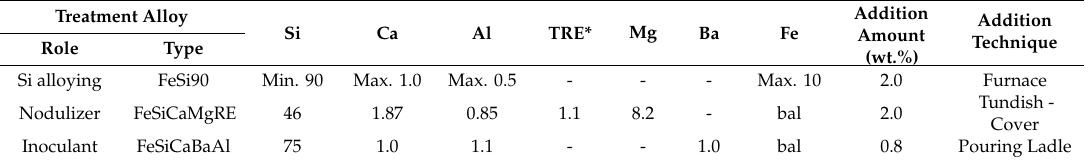
Table 1. Treatment alloys,